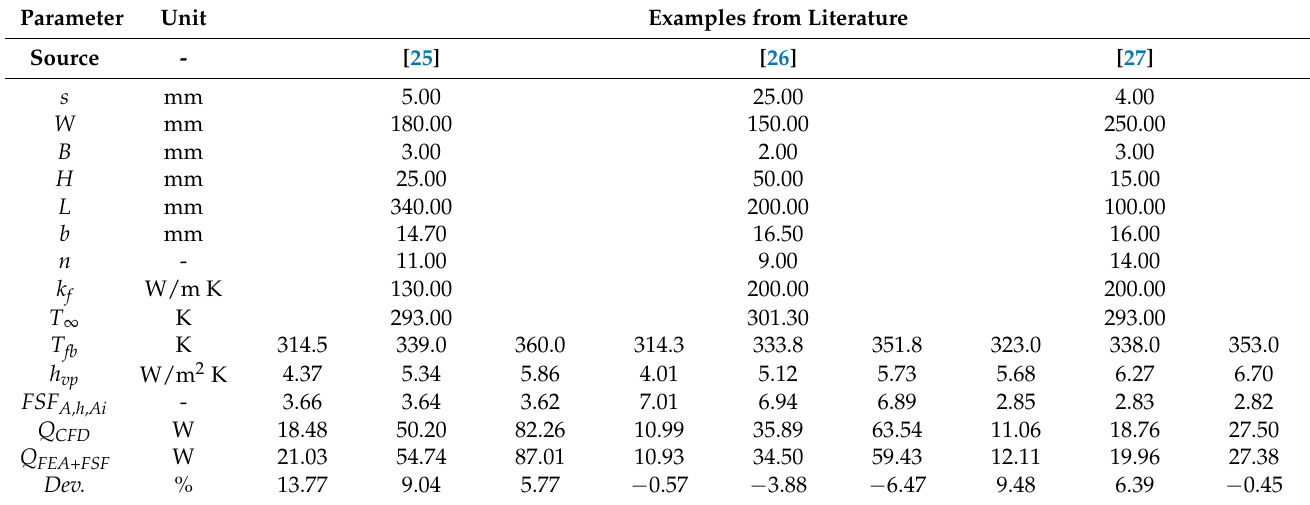
Table 6. Dimensions, boundary conditions, output and relative deviation of the finned